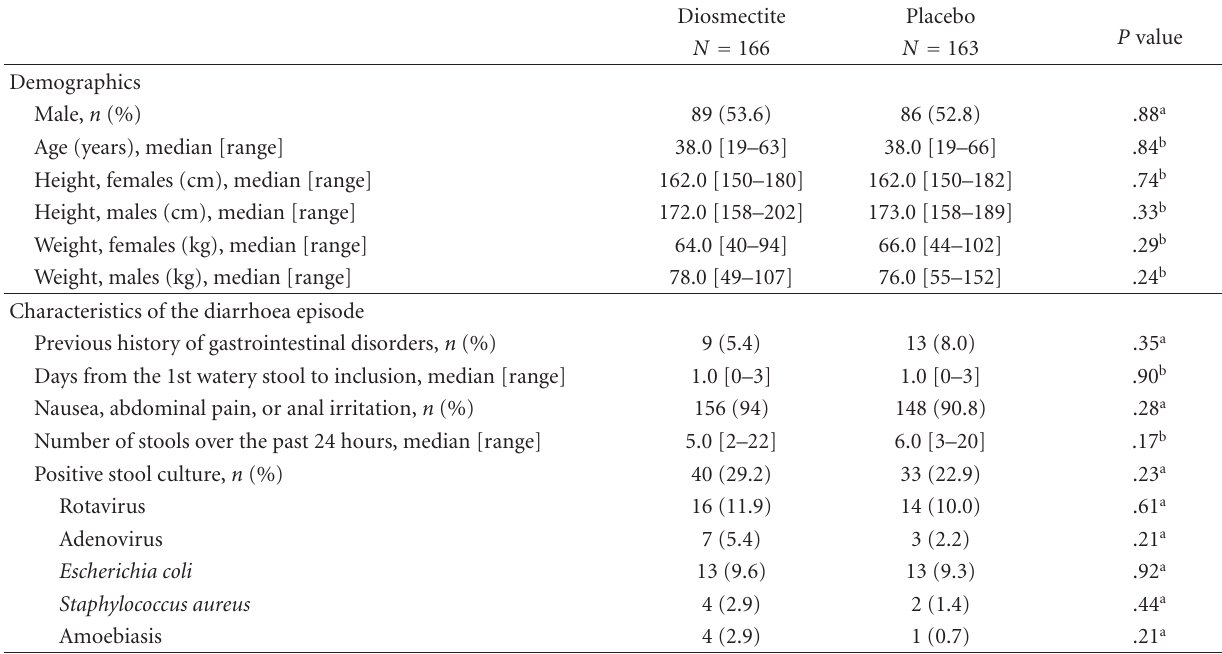
Table 1: Demographics, previous medical history, and characteristics of the acute diarrhoea episode.